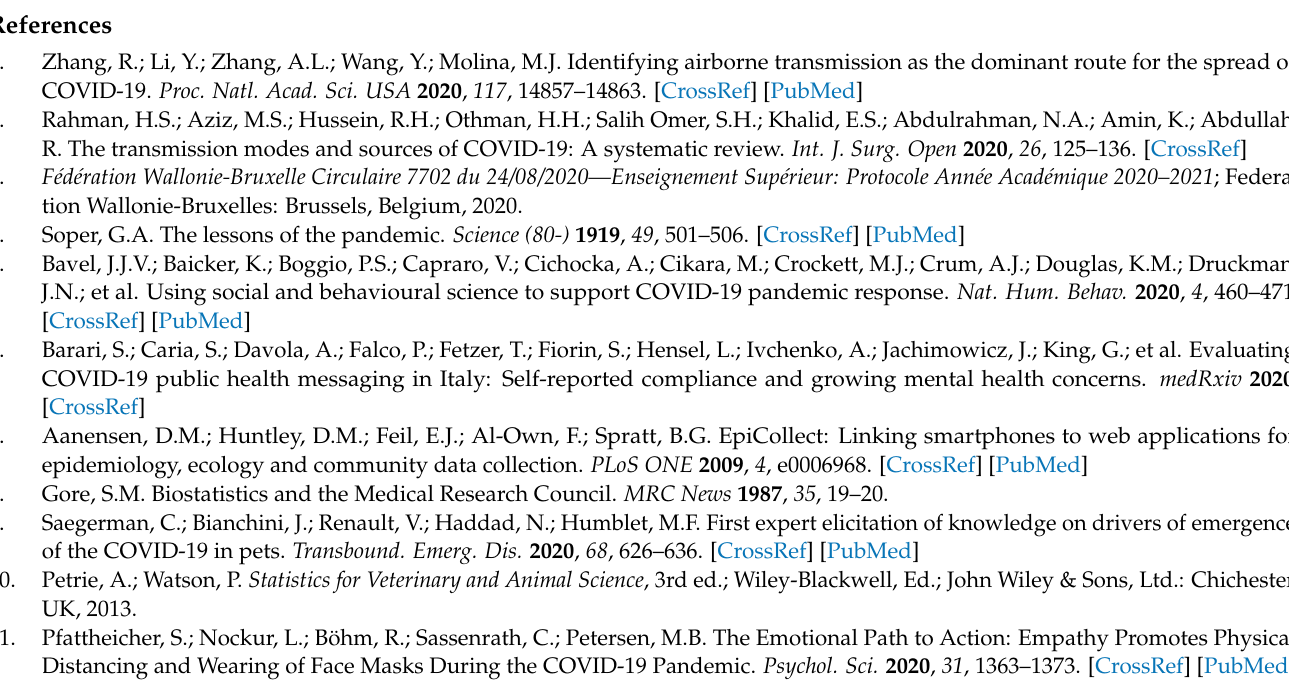
Figure A1. Graphical abstract presenting the feeding of the risk management barometer.